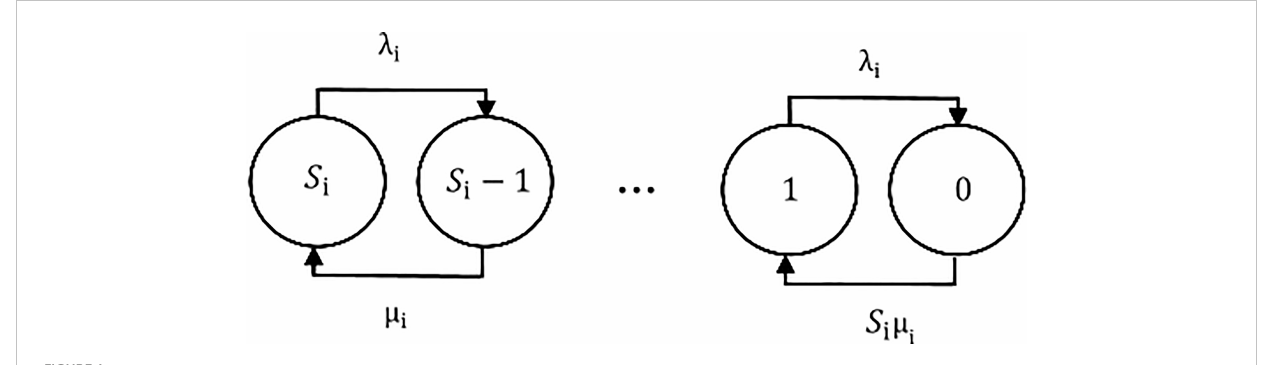
FIGURE 1 Empty-container repositioning order of port i